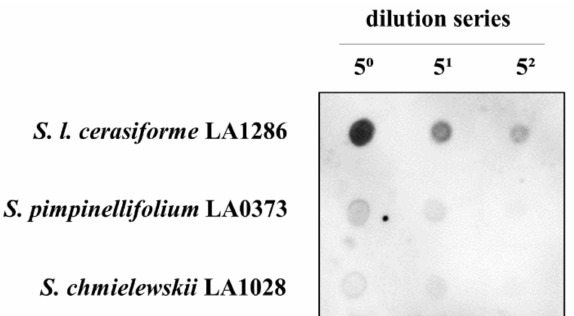
Figure 6. Low PSTVd accumulation in wild tomato relatives. Accumulation of PSTVd in wild tomato relatives was analyzed by dot-blot hybridization with a PSTVd-specific cRNA probe. Accumulation of PSTVd in S. pimpinellifolium LA0373 and S. chmielewskii LA1028 was lower than in a PSTVd-sensitive S. l. cerasiforme LA1286 at 3 weeks